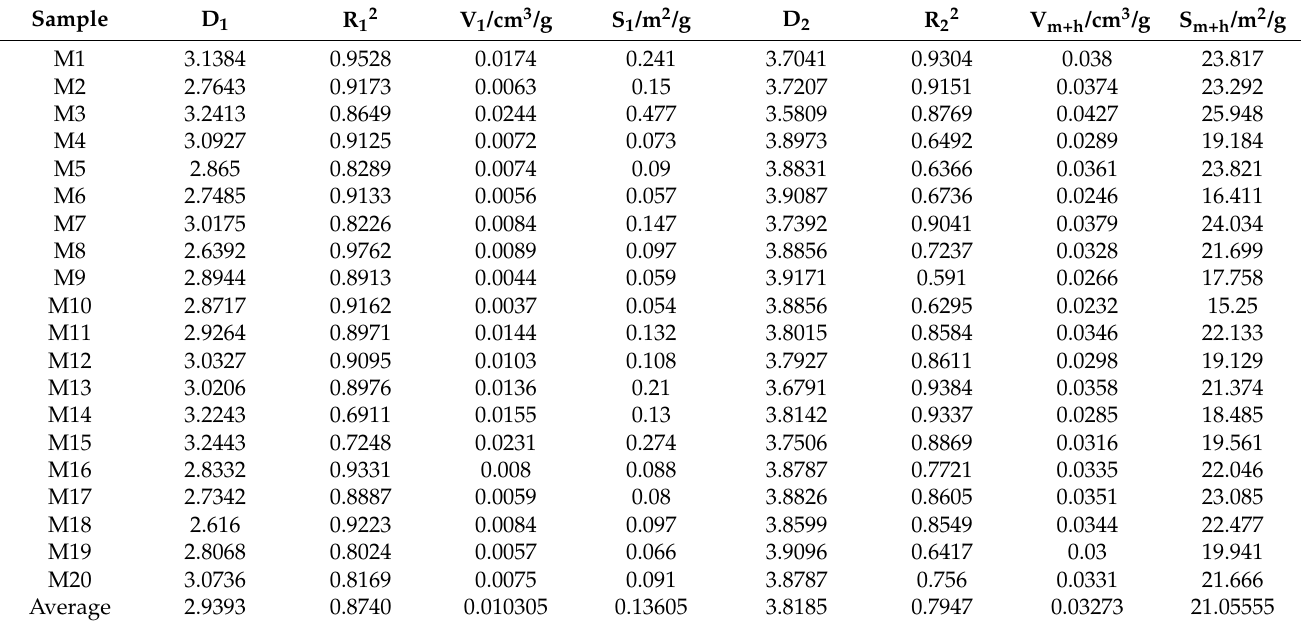
Table 4. Fractal characteristics of the HPMI analysis of coal samples.